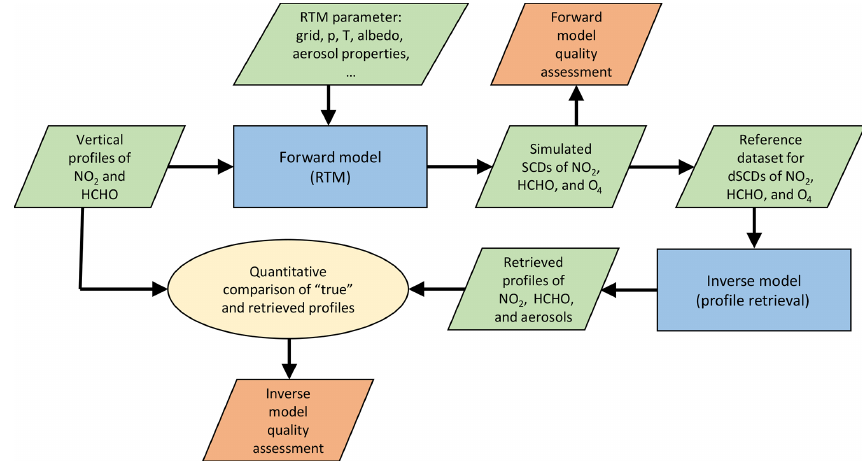
Figure 1. Flow diagram depicting the strategy for the retrieval algorithm intercomparison.